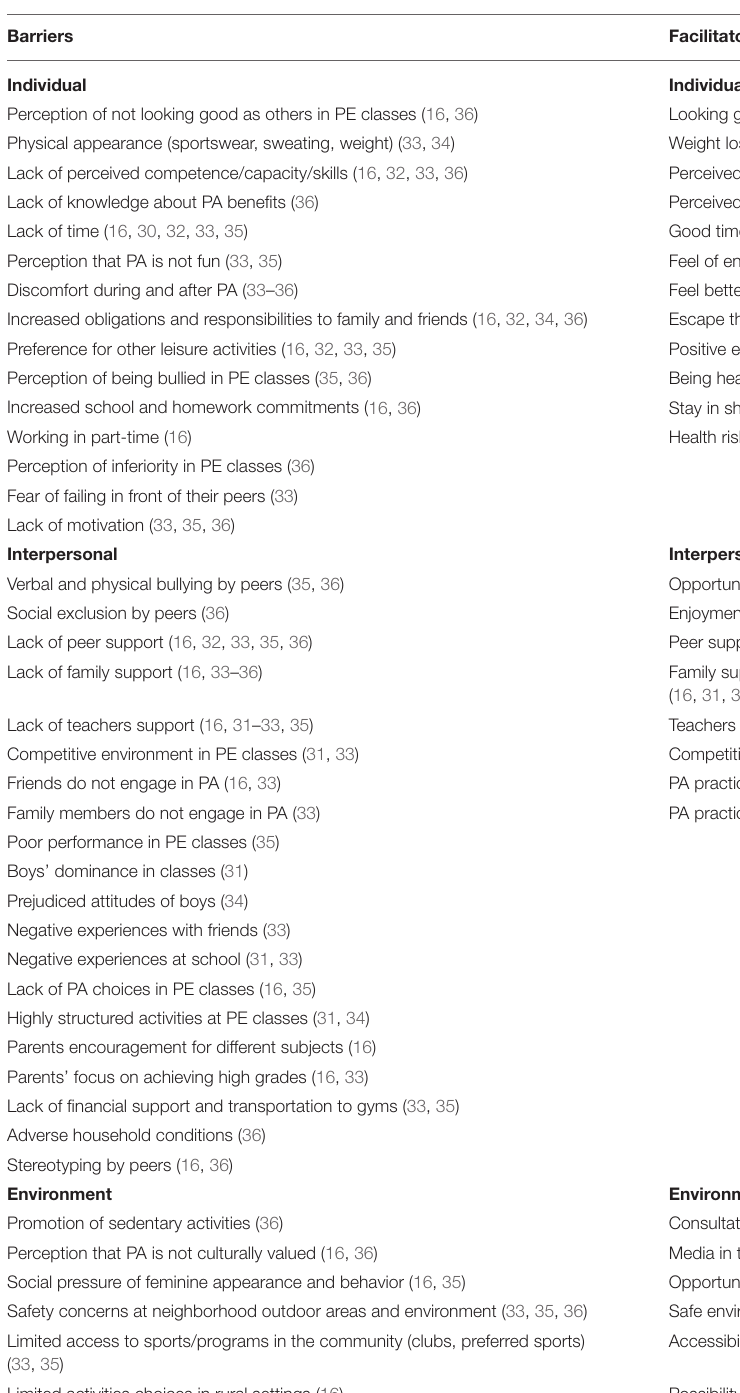
TABLE 4 | Summary of barriers and facilitators in the selected systematic